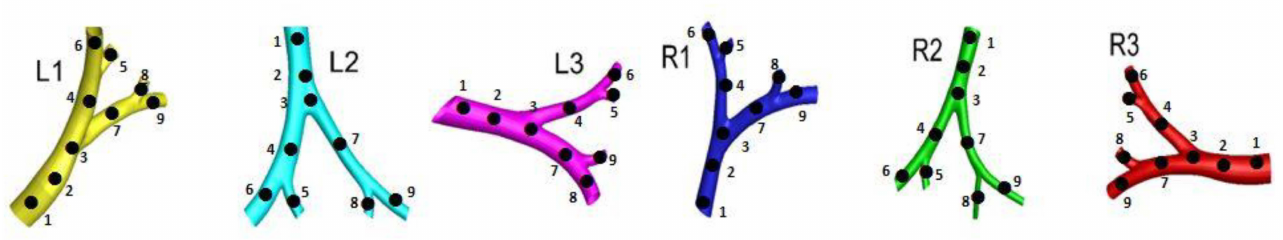
Figure 12. Selected points of the whole lung and local bifurcation. Figures 13 and 14 show the differences between bifurcations for the same side (right lung), the same generation (fourth), and different regions (upward and downward) of the local bifurcations instead of whole lung under mechanical ventilation and normal breathing conditions. It can be seen from Figure 13 that the upward bifurcation shows a higher velocity magnitude under mechanical ventilation. Moreover, the velocity streamtrace, pressure, and shear stress, are all stronger as shown in Figure 14. Under normal breathing, similar trends to that seen under the mechanical ventilation were observed.